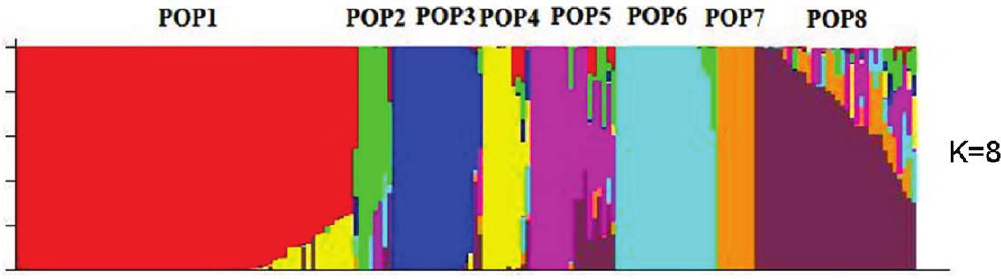
Figure 3. Population structure of Tibetan barley based on genetic diversity detected by 549 DArT markers. Each of the 188 Tibetan barley accessions is denoted as a vertical line, with the eight subgroups represented by different colors.